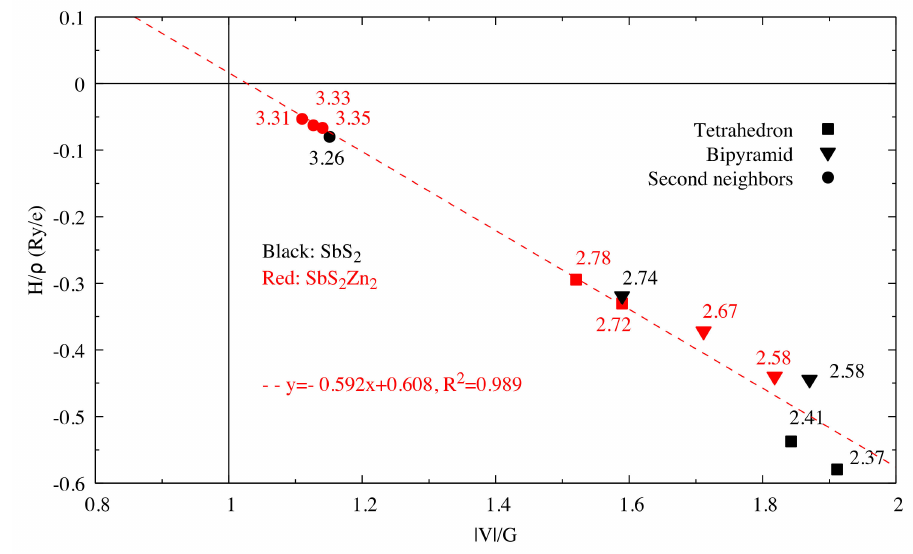
Figure 10. H b / ρ b vs. | V b | / G b for Sb–S interactions in SbS 2 and SbS 2 Zn 2